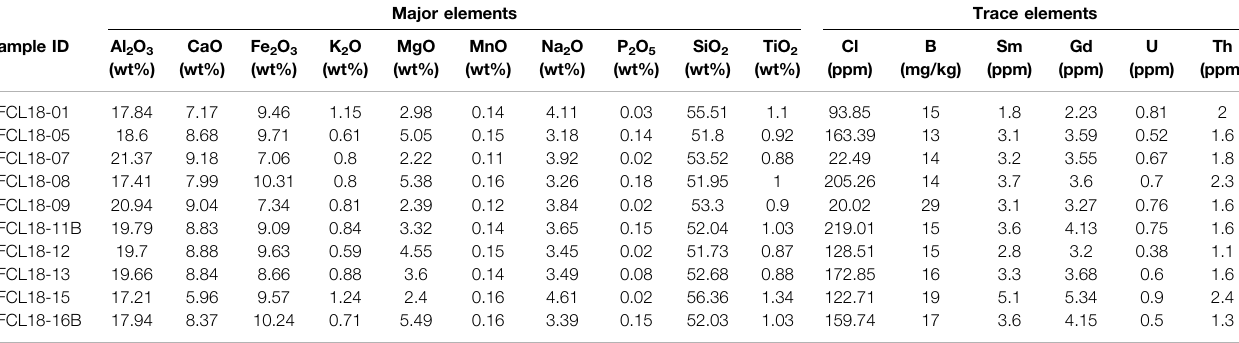
TABLE 3 | Elemental composition measured on whole rock samples after leaching. Major elements are in wt%, and trace elements in ppm unless noted otherwise. Major elements Sample